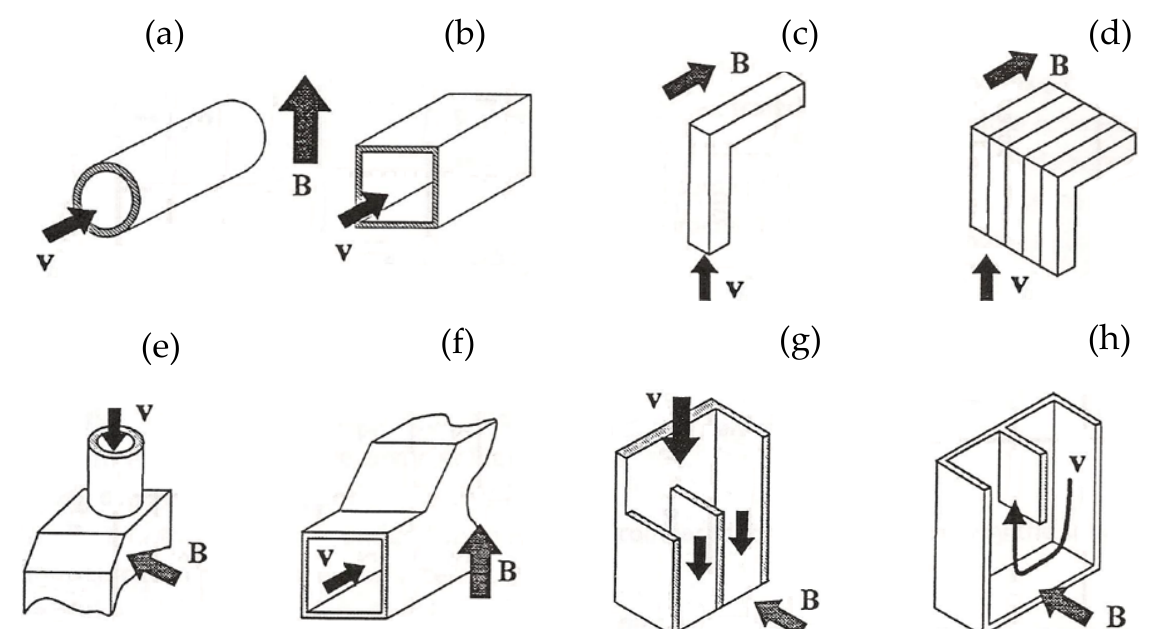
Figure 12. Basic 2D [( a ) and ( b )] and 3D [( c )–( h )] hydraulic elements of LM blankets: ( a ) circular pipe, ( b ) rectangular duct, ( c ) single-channel bend, ( d ) multi-channel bend, ( e ) sudden change of cross-section, ( f ) expansions and contractions, ( g ) manifold, ( h ) U-turn. All 2D and 3D elements can include FCIs to reduce the MHD pressure drop.